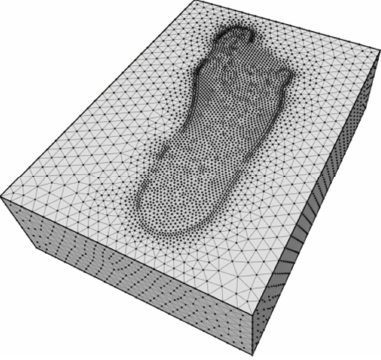
Figure 2. The digital model of the imprint Figure 4. FE mesh of the initial state of imprint mass Extraction of prescribed values of vertical displacements from the measured values was another task in the FEM input data preparation process. The nodes on the mesh measured were projected onto the XY plane and the nodes in the contact area of FE mesh were also projected onto XY plane. For the each contact area node of FE mesh, the corresponding triangular element of the mesh measured was searched, which the given FE node lied in. The resulting z -coordinate on the measured surface of the FE node was then calculated by the linear on the surface measured. Modelling of three middle fingers (II.,